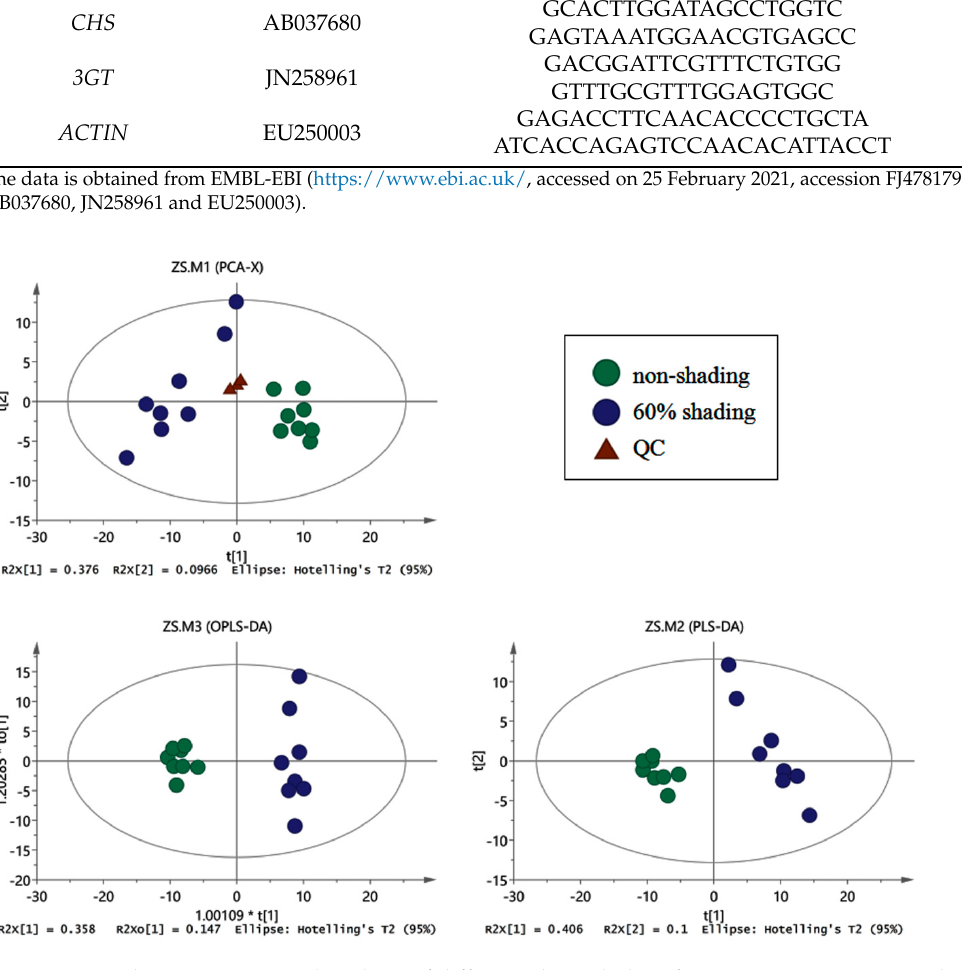
Figure A2. Classification of differential metabolites of PSP storage roots under shading treatment.